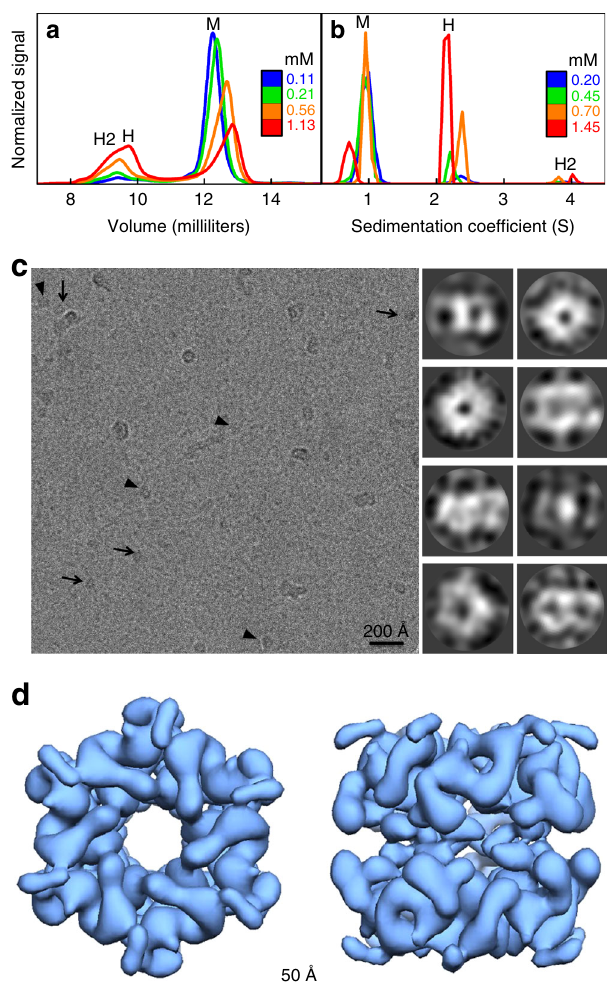
Fig. 3 Formation of toroidal hexameric – dodecameric assemblies in solution. a Size-exclusion chromatography of CI2 eng . The chromatogram shows one peak corresponding to the monomer (M) and a broader peak for the mixture of hexamer (H) and dodecamer (H2). b Analytical ultracentrifugation of CI2 eng resolving the three species: monomer (M), hexamer (H), and dodecamer (H2). c (Left) cryo-image of CI2 eng in solution. Arrows point to end-on views and arrowheads to tilted views of the particles. (Right) gallery of representative 2D classes classi fi ed with Relion 68 . Doughnut shapes represent end-on views and the other shapes various side views of the CI2 eng assembly. d 3D reconstruction at sub-nm resolution of the CI2 eng assembly formed in